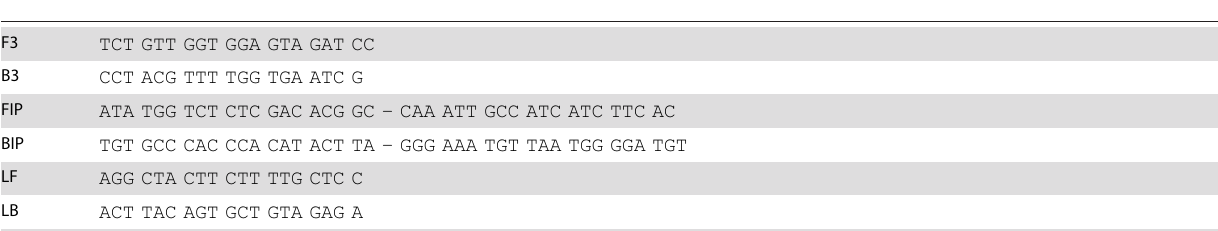
Table 1. P. vivax r64 RealAmp primer set sequence (5 9 R 3 9 ).